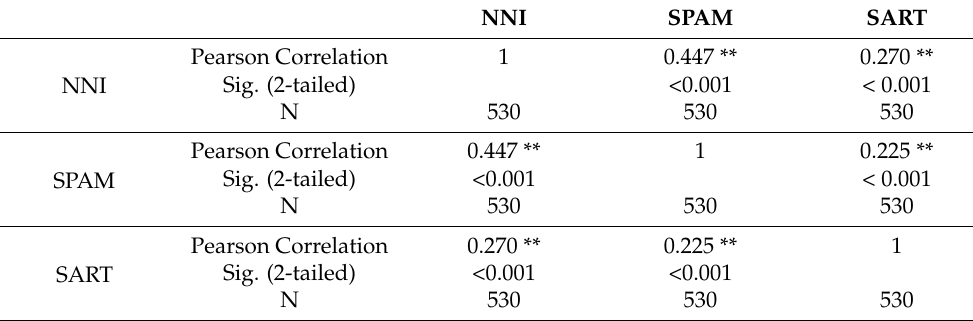
Figure 10. Interaction effects of NNI across UI levels and presentation frames. Note. Non-estimable means are not plotted, so UI1 is represented by a dotted line: UI1 contains a small amount of VIS, and only two presentation frames exist in this interface, a positive frame (PP) and a negative frame (NN), with no combined frames (PN and NP). Table 9. NNI and SPAM correlation